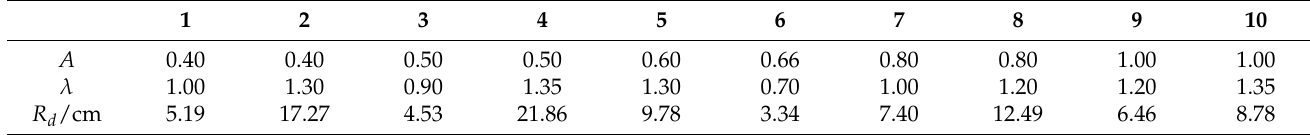
Table 1. The radius of spiral climbing gaits by PSO.